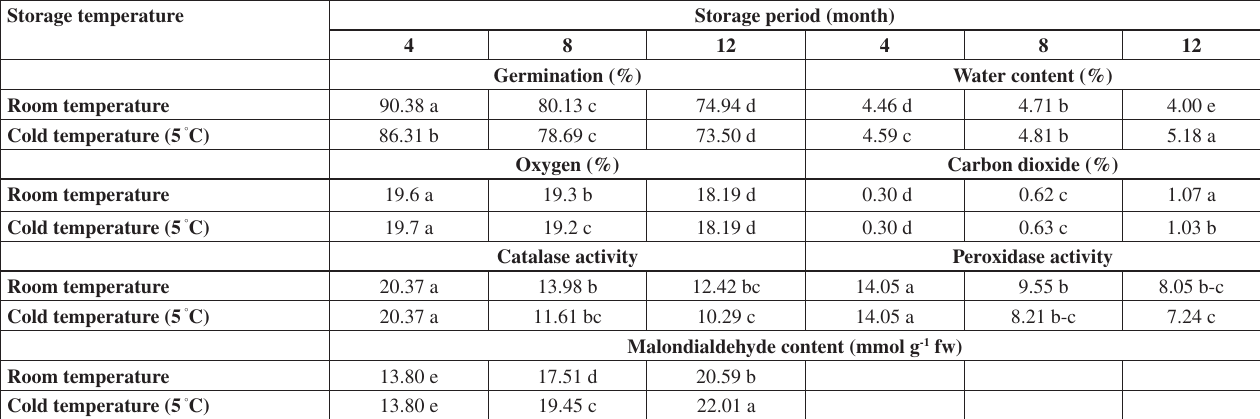
Table 3: Effect of the interaction between storage temperature and storage period on germination (%) water content (%), oxygen and carbon dioxide percentages, catalase and peroxidase activities malondialdehyde content of onion seeds Storage